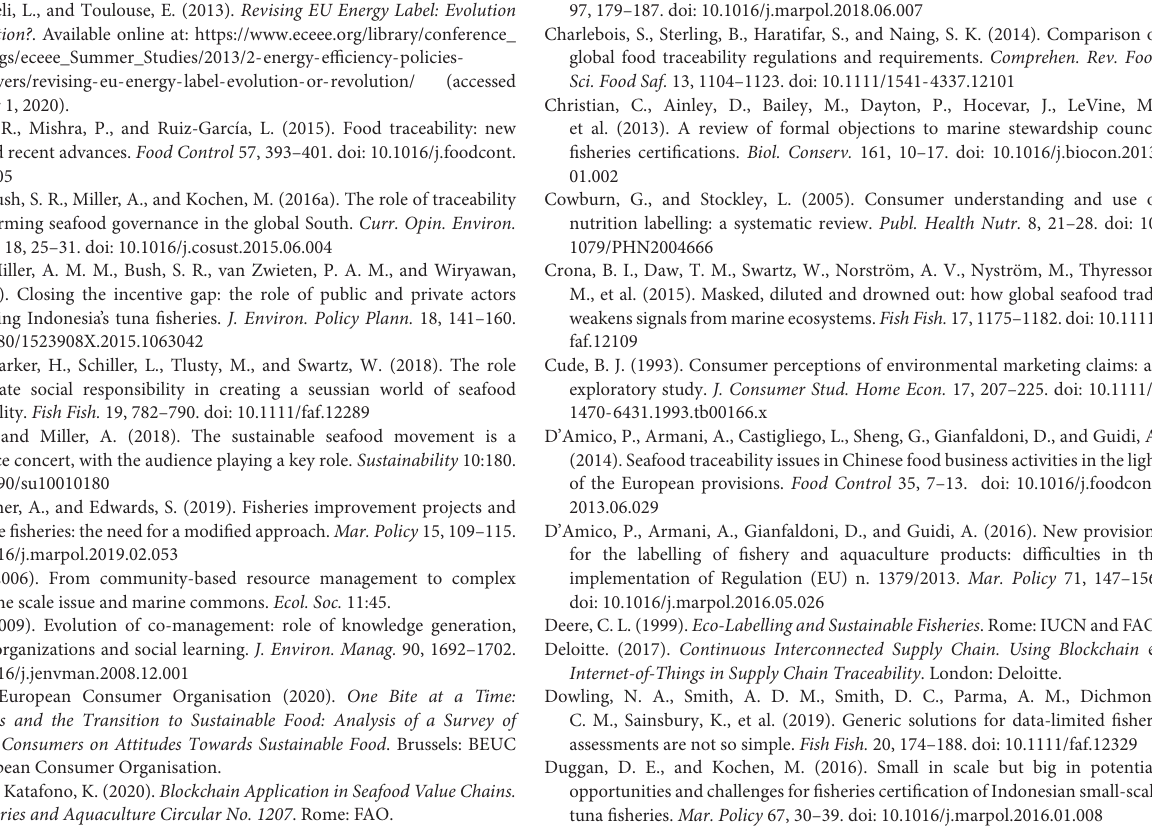
Supplementary Figure 2 | Example of European Union requirements for labeling of unprocessed and pre-packaged products, Courtesy of Oceana,